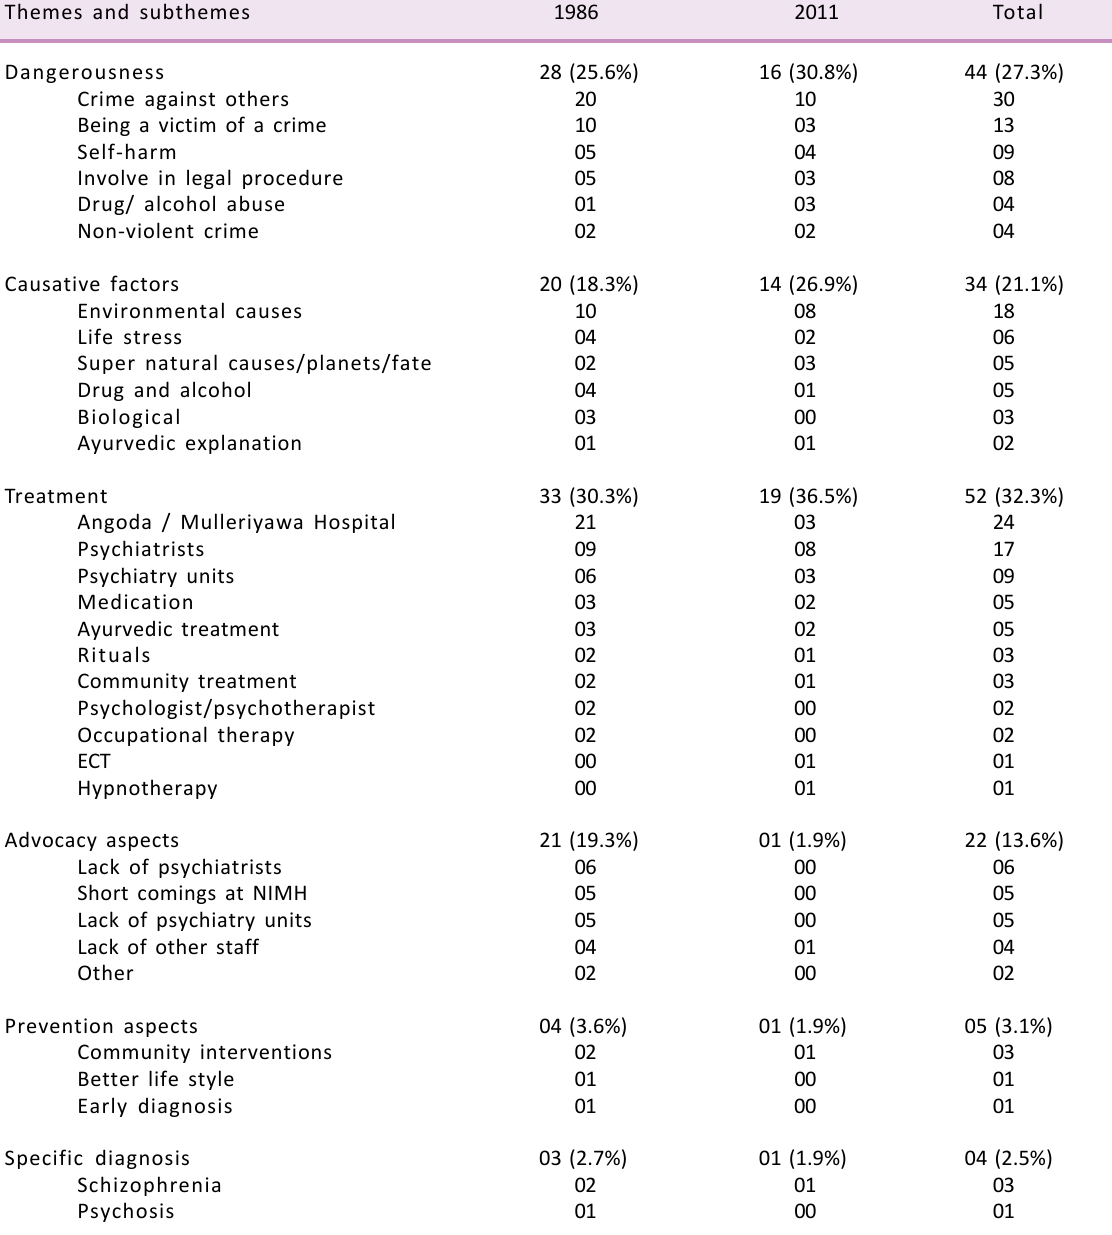
Table 2. Themes and sub themes of the articles directly related to psychosis, which appeared in two Sinhalese newspapers over the study period, with the number of articles Themes and